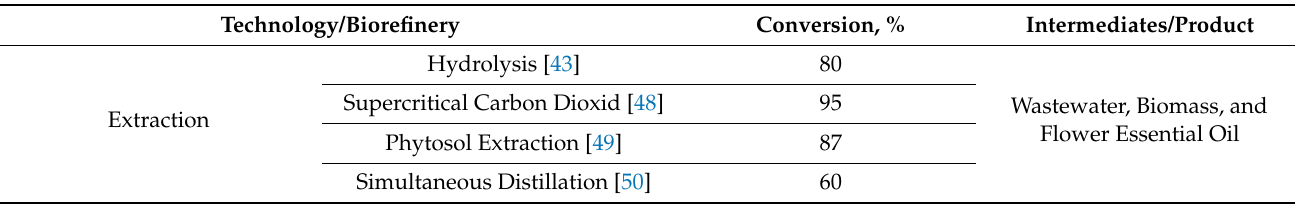
Table 6. Conversion factor of extraction